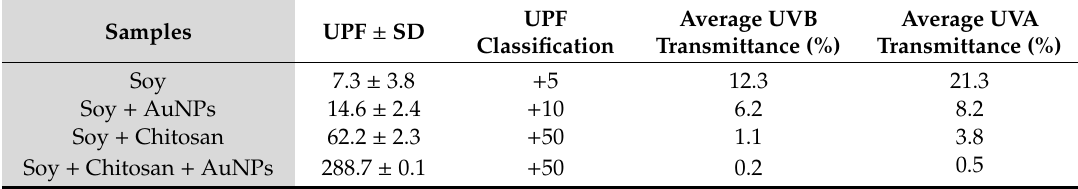
Table 5. Ultraviolet protection factor (UPF) and percent of UV-light transmission (UVB radiation, 280–315 nm, and UVA radiation, 315–400 nm) of bare, chitosan, AuNPs and AuNPs functionalized soy fabrics pre-treated with